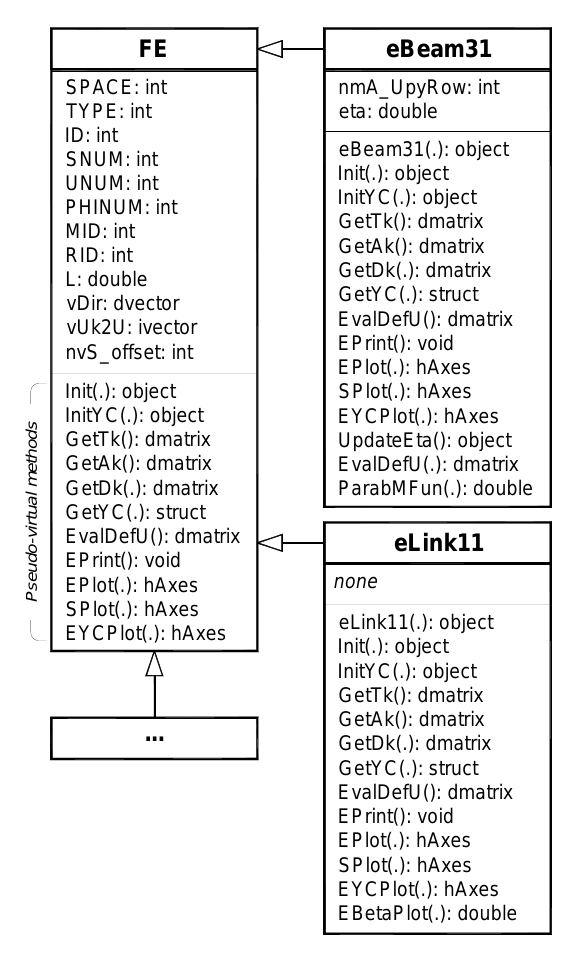
Fig. 17. UML diagram of finite element classes